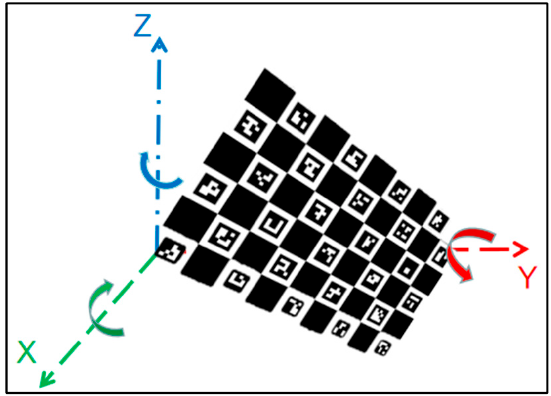
Figure 6. Positive rotation direction of the coordinate axis.